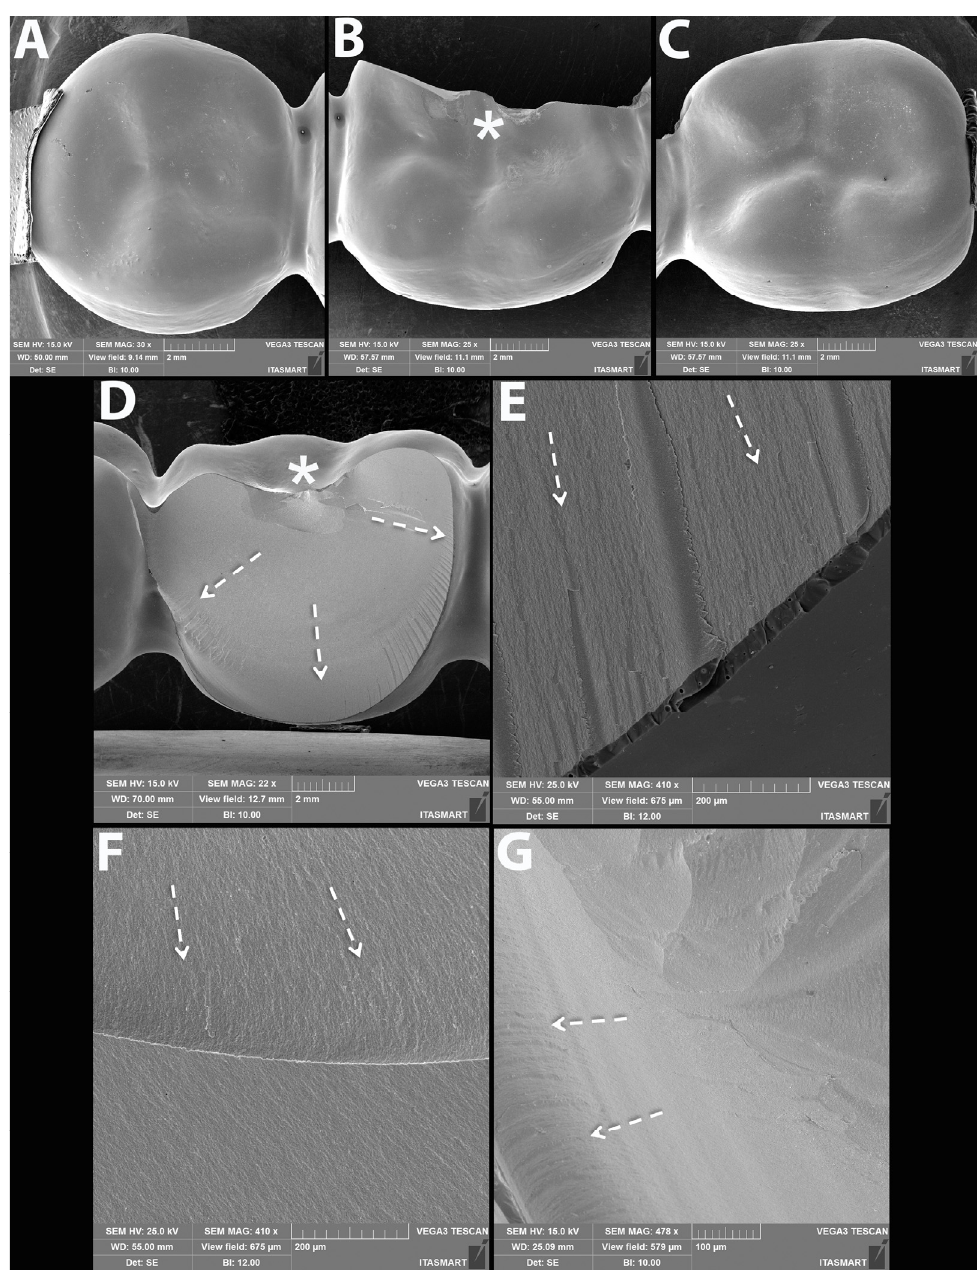
Figure 8. SEM micrographs of fractured FDP from Group FL. Occlusal views of abutments ( A , C ) and pontic ( B ) of an FDP showing the fracture initiation site at the asterisk. ( D ) is a buccal overview of the fractured surface of the pontic showing the origin (asterisk) and direction of crack propagation (dotted arrows). Clockwise magnification of ( D ) is presented in subsequent micrographs ( E – G ) where dotted arrows point at the hackle lines indicating the direction of crack propagation from the occlusal surface towards the margins.